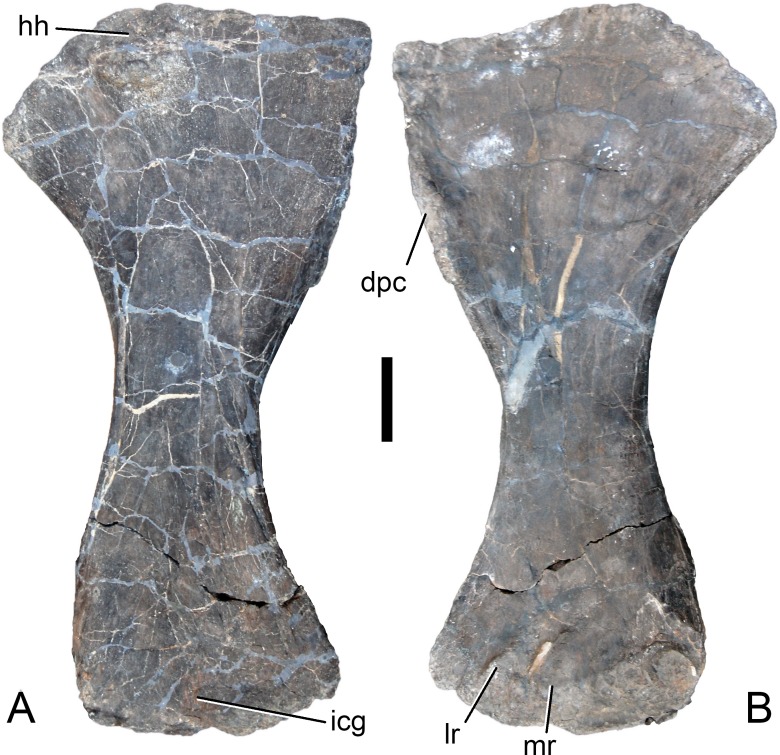
Right humerus of Galeamopus pabsti SMA 0011.The humerus is shown in posterior (A) and anterior (B) views. Abb.: dpc, deltopectoral crest; hh, humeral head; icg, intercondylar groove; lr, lateral ridge; mr, medial ridge. Scale bar = 10 cm.